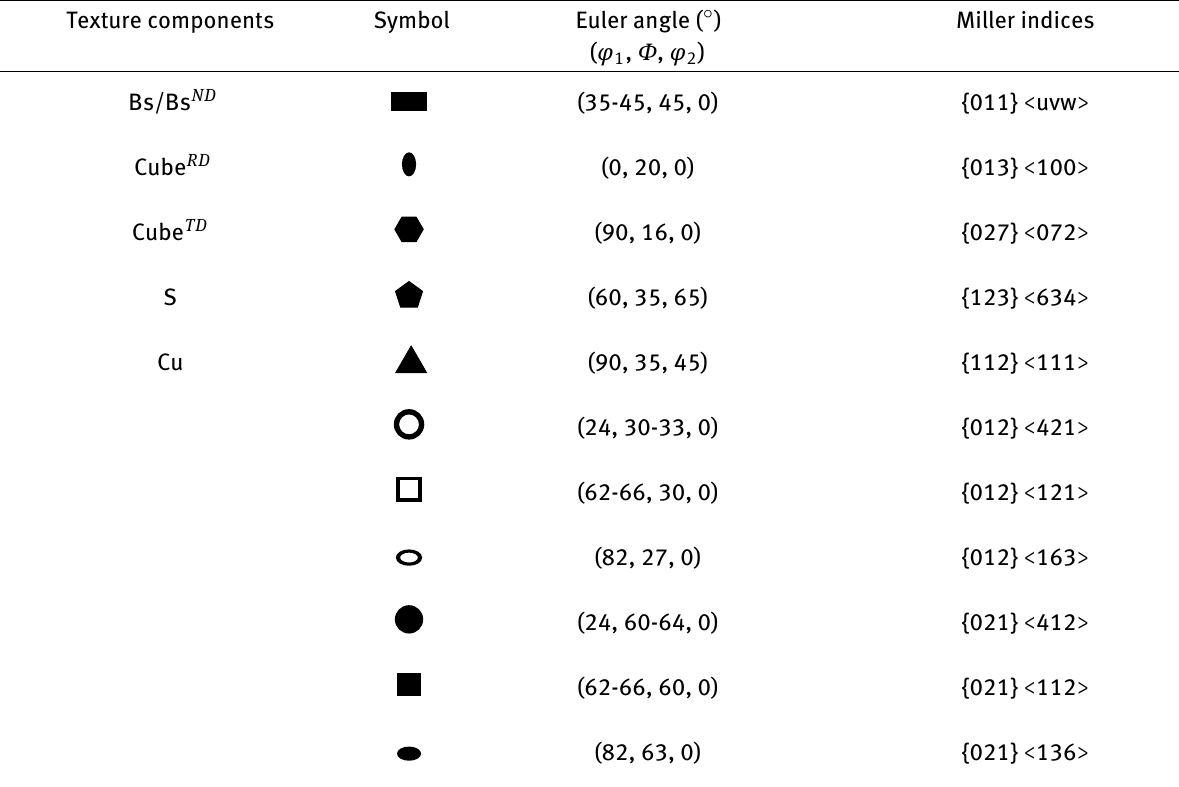
Table 1: Important deformation and recrystallization texture components in CCR samples. Texture components